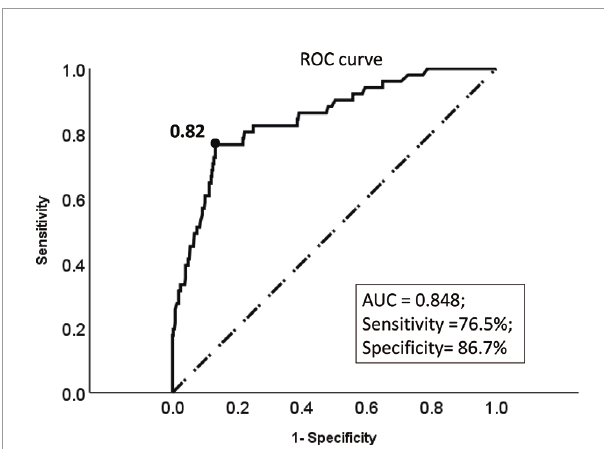
FIGURE 4 | The ROC curve of the optimal threshold value of the 3-year recurrence-free survival rate predicted by the model. Description: Black dot: the area under the curve at this point is the largest, which indicates the optimal threshold value of the 3-year recurrence-free survival rate predicted by the model is 0.82 (area under the curve = 0.848; sensitivity, 76.5%; speci fi city, 86.7%); (Dotted line: reference line; Solid line: the ROC curve of the model).